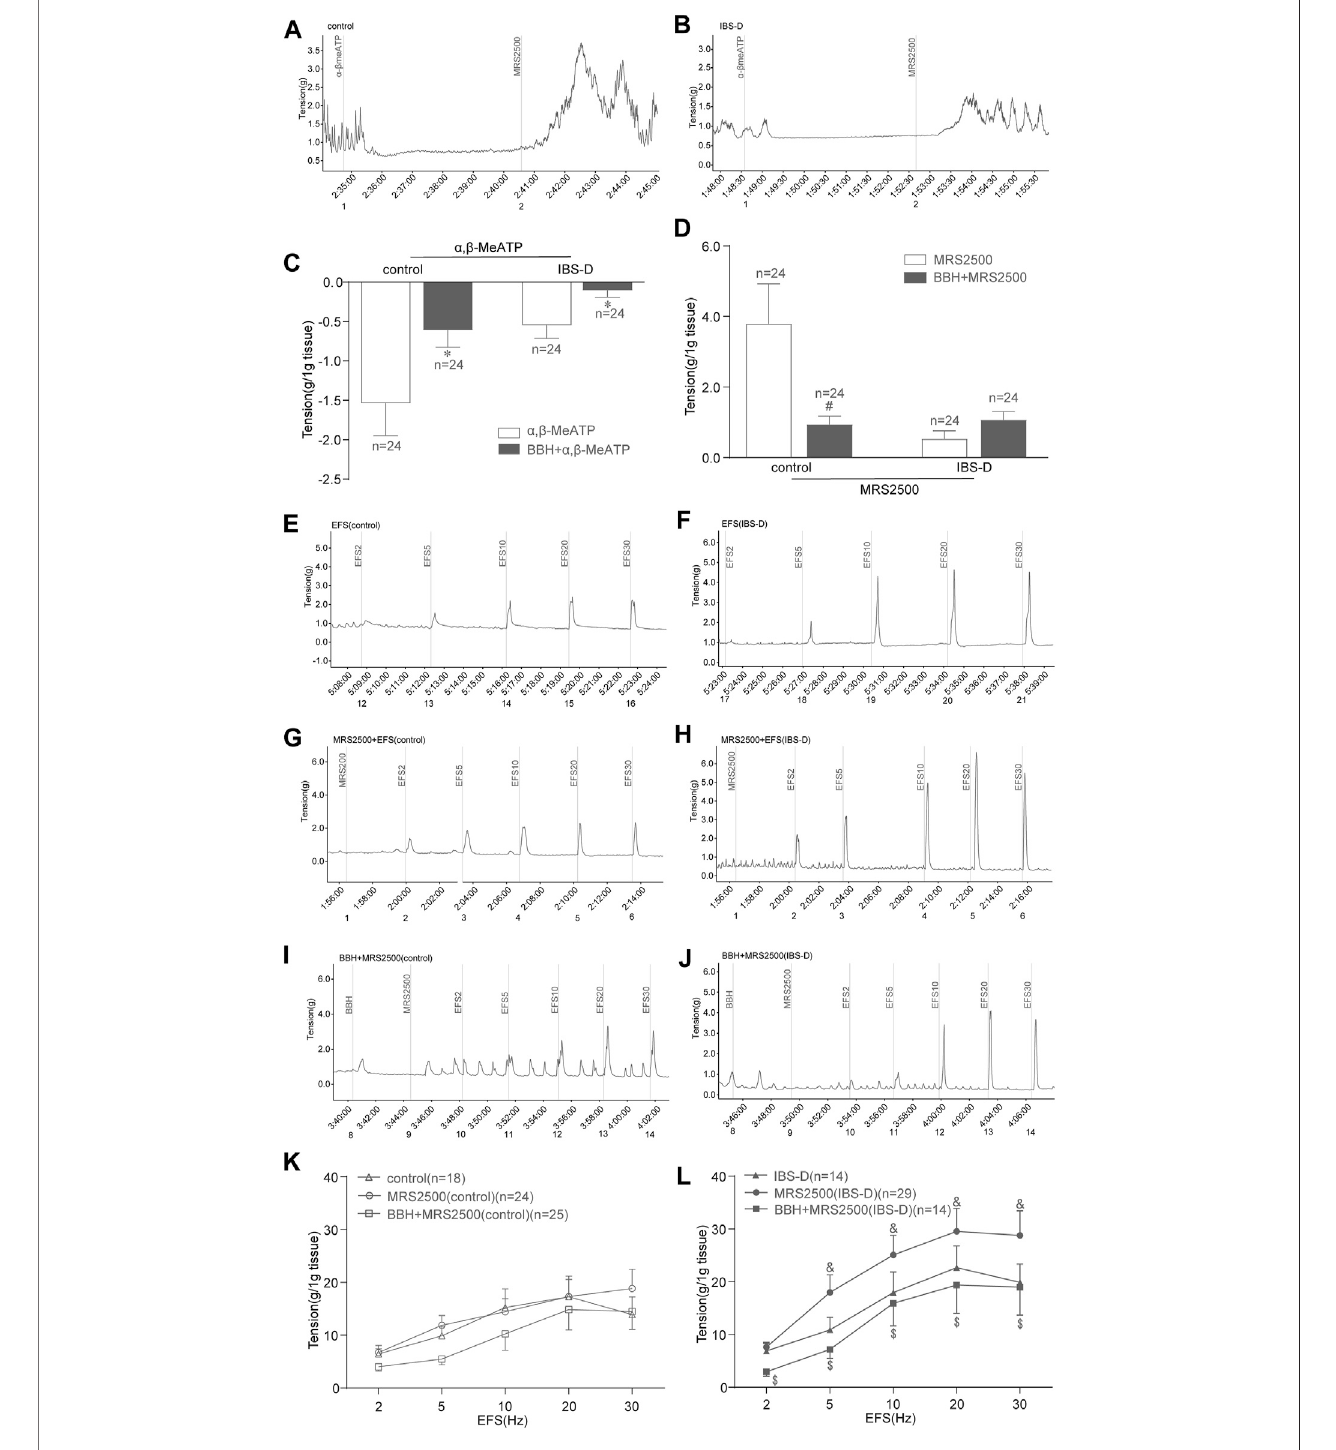
FIGURE 8 | BBH inhibited the EFS-induced contractile responses of isolated colonic longitudinal smooth muscles treated with P2Y 1 receptor antagonist. Mechanical recording (A, B, and E – J) , histogram (C,D) , and line chart (K,L) of the inhibitory effect of BBH on the tension of the α , β -MeATP-treated and MRS2500-treated isolated colonic longitudinalsmoothmusclesinthecontrolandIBS-Dgroups. (A) : α , β -MeATP-treated( n (cid:2) 24)andMRS2500-treated( n (cid:2) 24)controlgroups. (B) : α , β -MeATP-treated( n (cid:2) 24)and MRS2500-treated ( n (cid:2) 24) IBS-D groups. (C) : *denotes p < 0.05 compared with the α , β -MeATP-treated group. (D) : # denotes p < 0.05 compared with the MRS2500- treatedcontrolgroup. (E) EFS-inducedcontrolgroup( n (cid:2) 18). (F) :IBS-Dgroup( n (cid:2) 14). (G) :EFS+MRS2500-treatedcontrolgroup( n (cid:2) 24). (H) :EFS+MRS2500-treatedIBS-D group( n (cid:2) 29). (I) :BBH+MRS2500-treatedandEFS-inducedcontrolgroup( n (cid:2) 25). (J) :BBH+MRS2500-treatedandEFS-inducedIBS-Dgroup( n (cid:2) 14). (K) :Inhibitoryeffectof BBHontheMRS2500-treatedcontrolgroup. (L) :InhibitoryeffectofBBHontheMRS2500-treatedIBS-Dgroup&denotes p < 0.05comparedwiththeEFS-inducedIBS-Dgroup. $ denotes p < 0.05 compared with the EFS + MRS2500-induced IBS-D group. Error bars represent mean ± SEM.